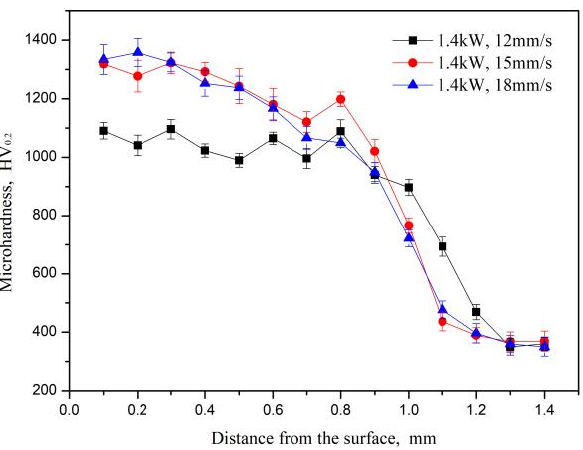
Figure 7. The hardness distributions of the coatings under different scanning speeds.